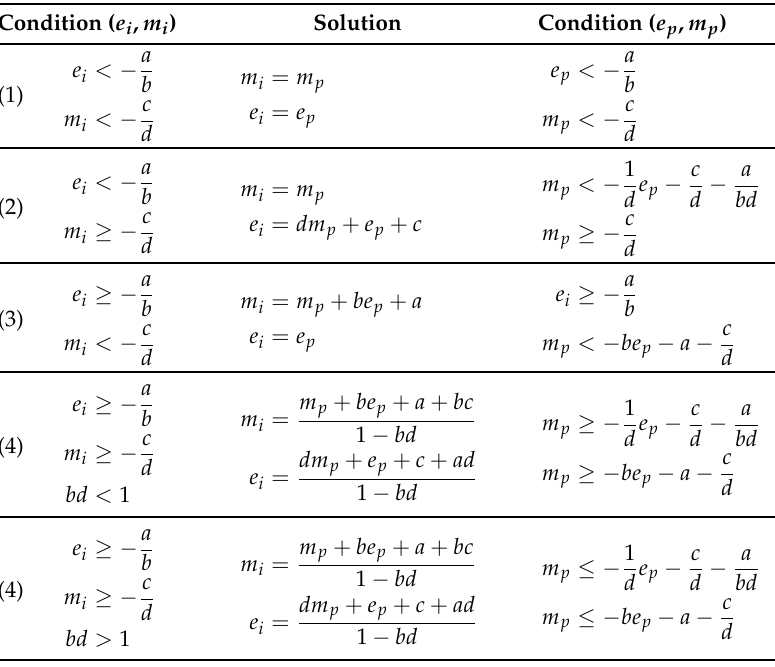
Table 4. Exact solutions for four conditions. Note that Condition 4 is subdivided into two cases: bd < 1 and bd >